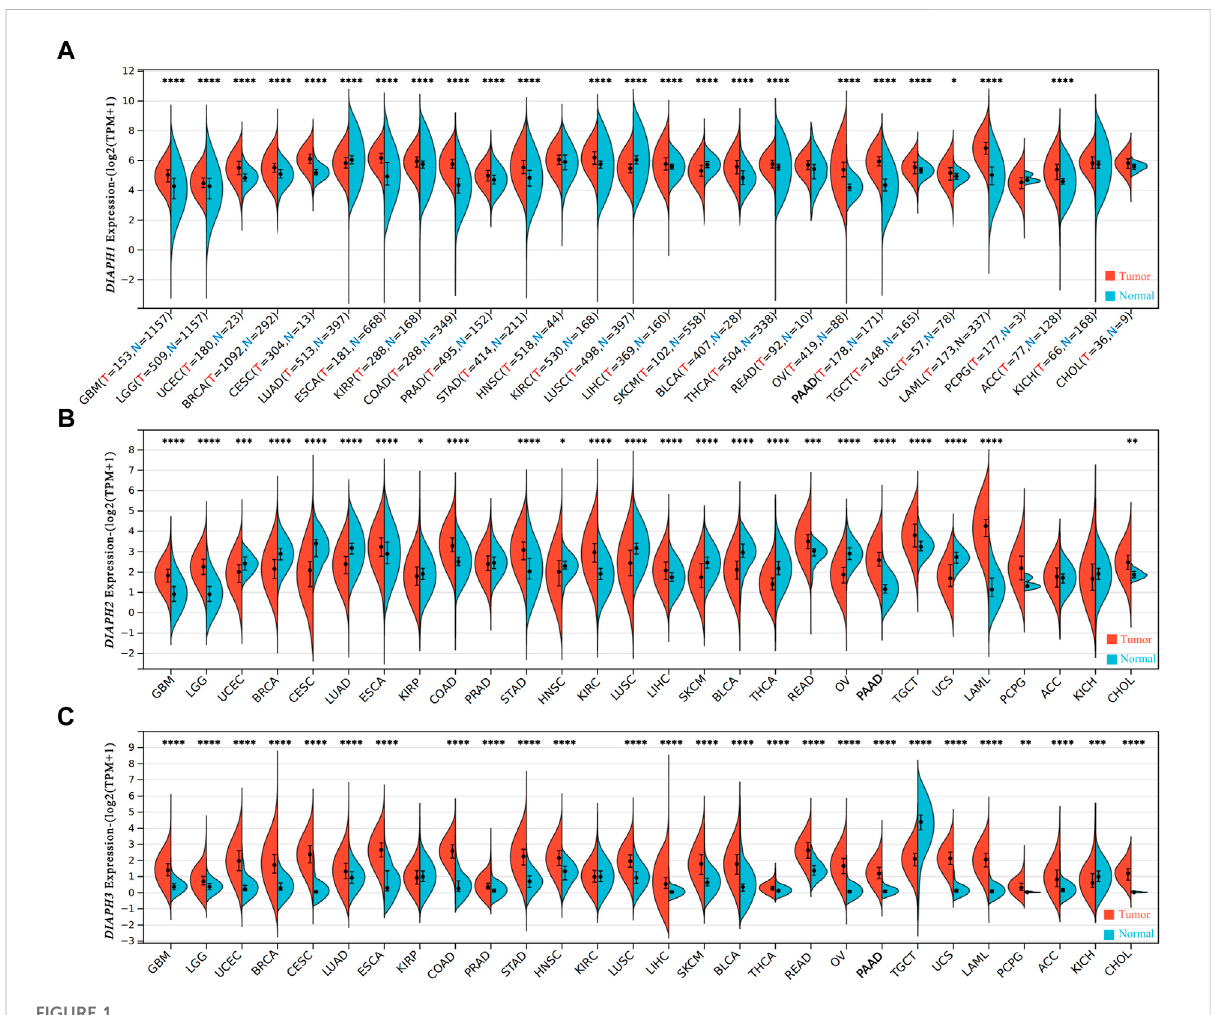
FIGURE 1 mRNA expression levels of DIAPHs in pan-cancer. (A) DIAPH1 expression. (B) DIAPH2 expression. (C) DIAPH3 expression. Log 2 (TPM+1) transformedtheexpressiondata for plotting.* p < 0.05, ** p < 0.01,*** p < 0.001, **** p < 0.0001,in Wilcoxon test. TPM, transcripts per million; N and T, normal and tumor